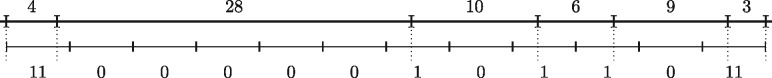
Transforming the Rmap [4,28,10,6,9,3] to a binary string. The block size in this example is 5